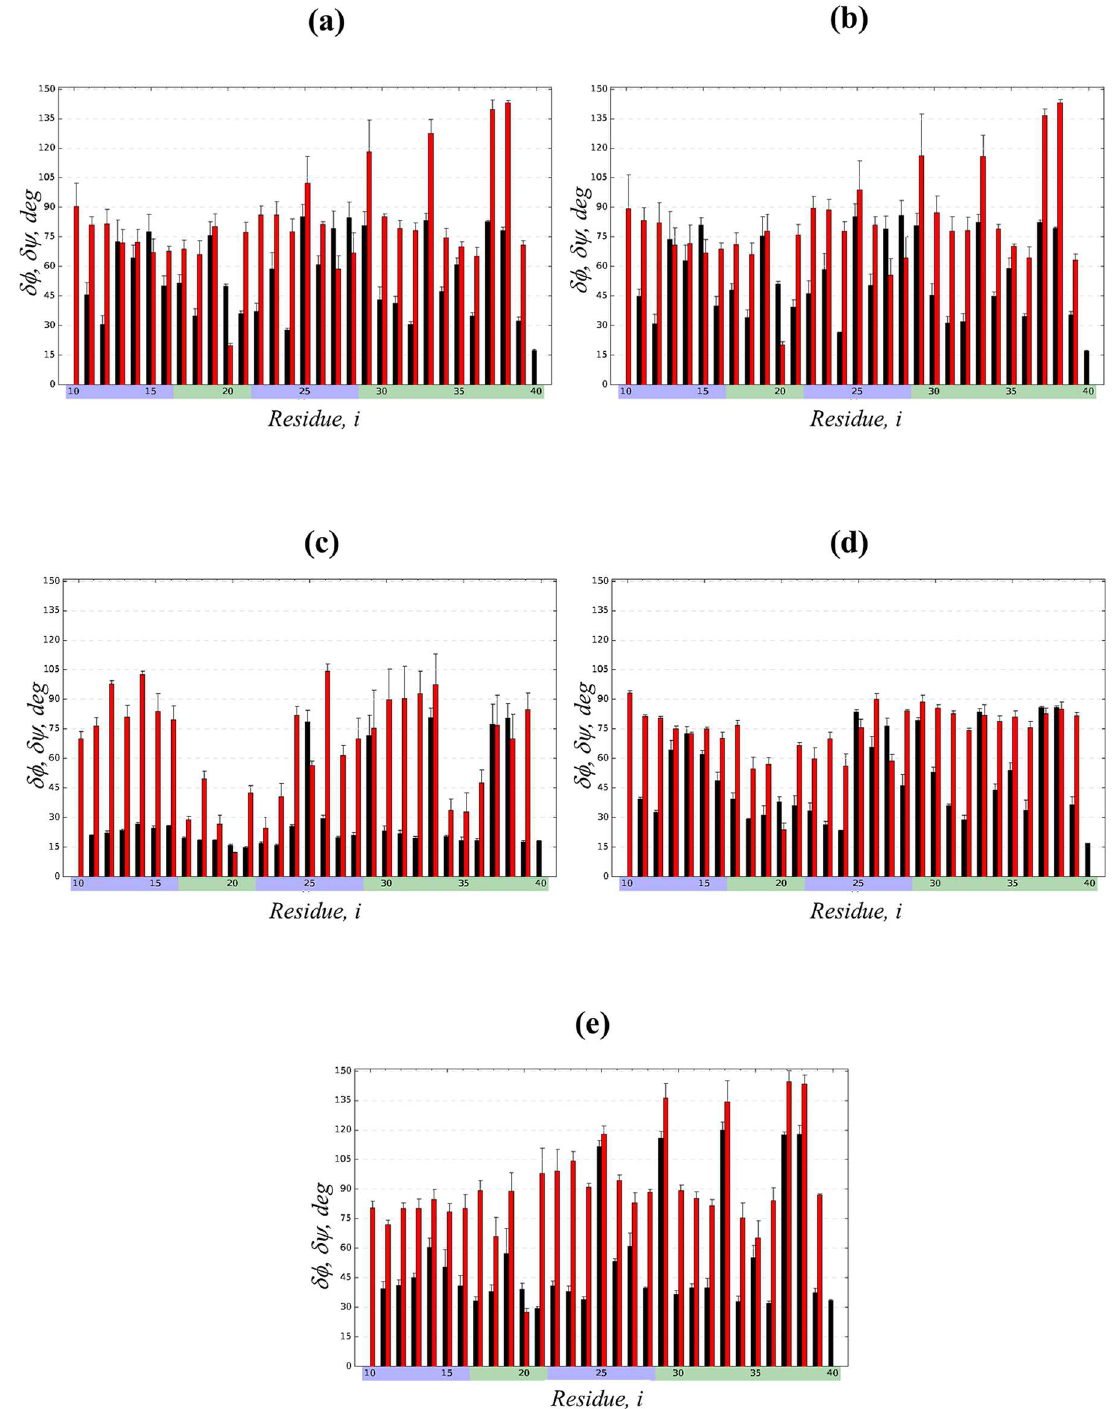
Fig 4. A β backbone fluctuations in different force fields. Root-mean-square fluctuations (RMSF), δ ϕ ( i )(black bars) and δψ ( i ) (red bars), in the backbonedihedralangles ϕ and ψ for A β 10-40amino acids i computedin five force fields: (a) C36, (b) C36s, (c) C22 * ,(d) C22cmap, and (e) OPLS-AA. Sampling errors are shownby vertical bars. Sequenceregionsare identifiedby the color scheme used in Fig 1a. The plots show that out of all force fields C22 * predicts the most rigid backbone,especiallyin S2 and S4